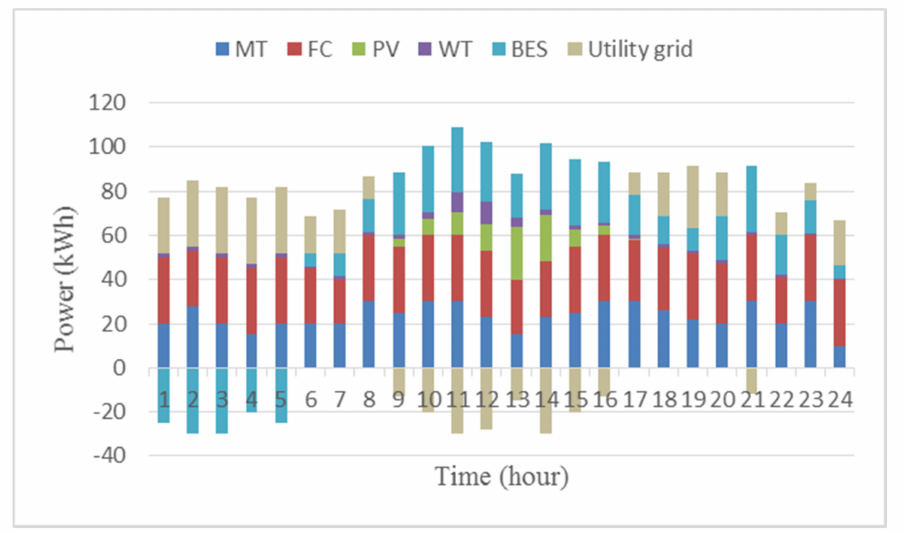
Figure 11. Optimal output of the generation sources obtained by GWO for Scenario